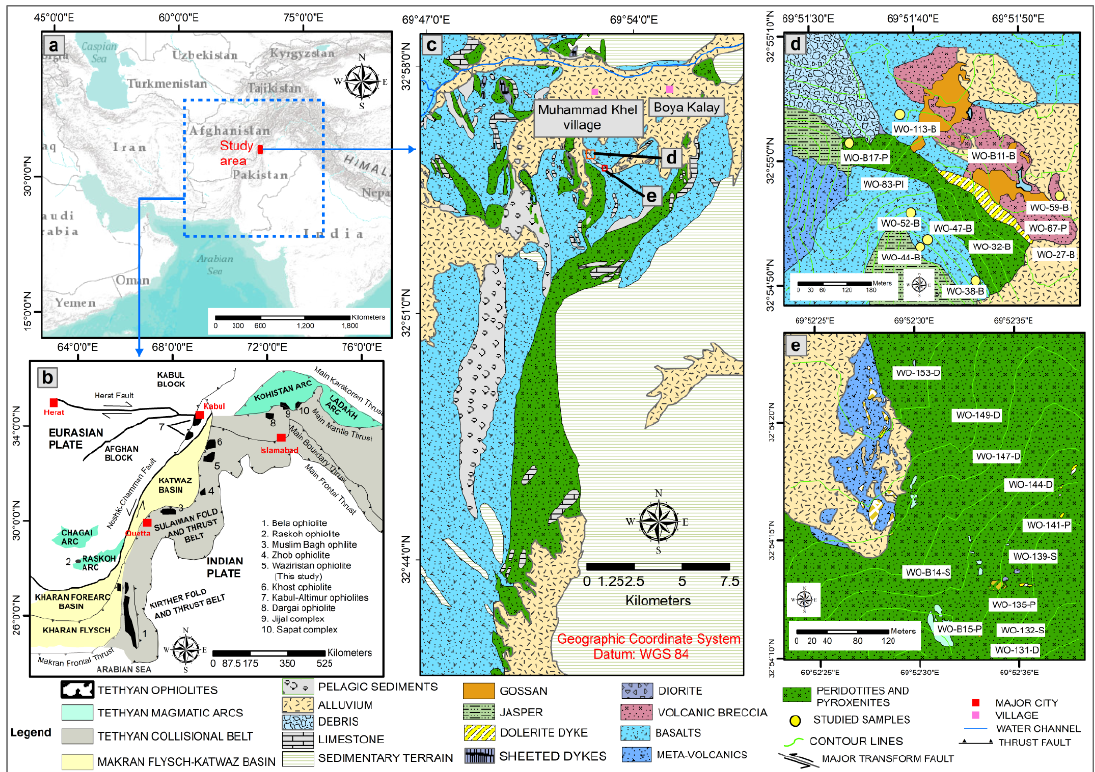
Figure 1. ( a ) General map showing the location of the study area; ( b ) Tectonic map showing the Neo-Tethyan sutures and ophiolite occurrences in Pakistan and adjacent regions (modified after [17,38,39]); ( c ) Simplified geological map of part of the Waziristan ophiolite complex (WOC) and surrounding region (modified after Badshah et al. [40]), showing locations of the studied two sections; ( d , e ) Local geological maps of the studied sections of the WOC showing spatial distribution and sample locations. See Supplementary Table S1 for coordinates of the studied samples.